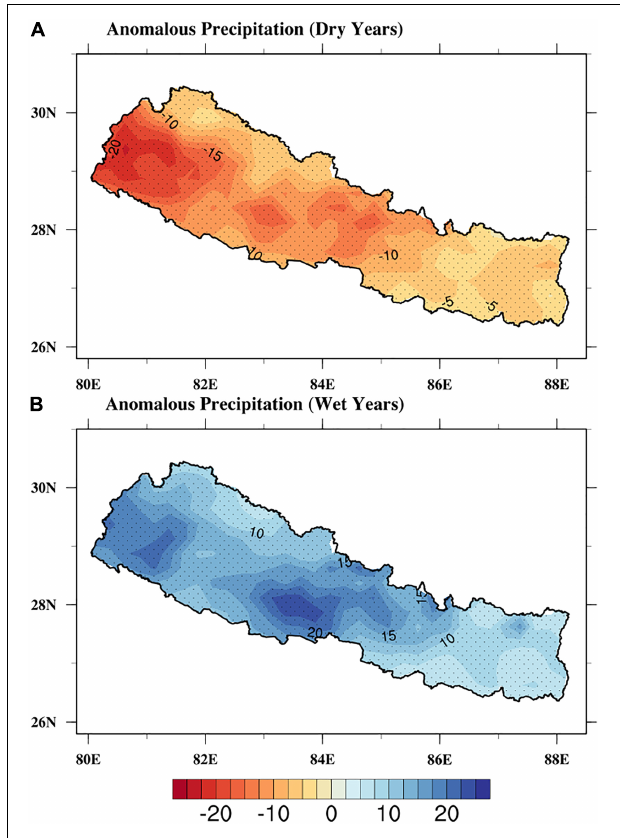
FIGURE 8 | Composite precipitation anomalies (mm/month) for (A) dry years and (B) wet years based on APHRODITE data between 1987 and 2015. The dotted points represent the significance at a 95% confidence